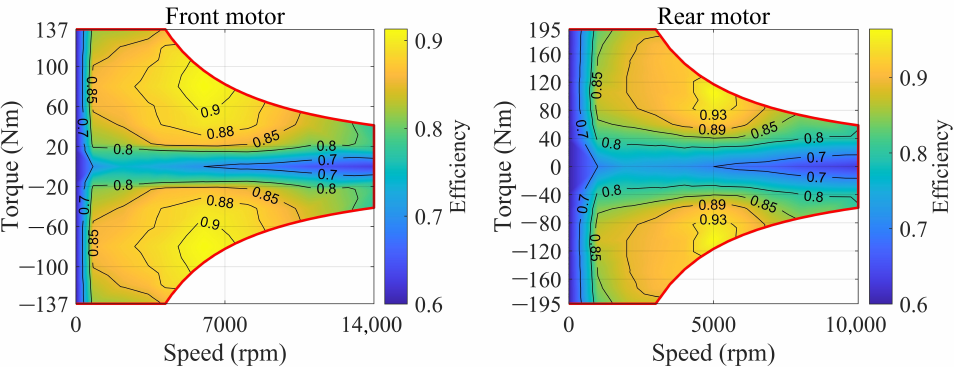
Figure 4. Front and rear motor